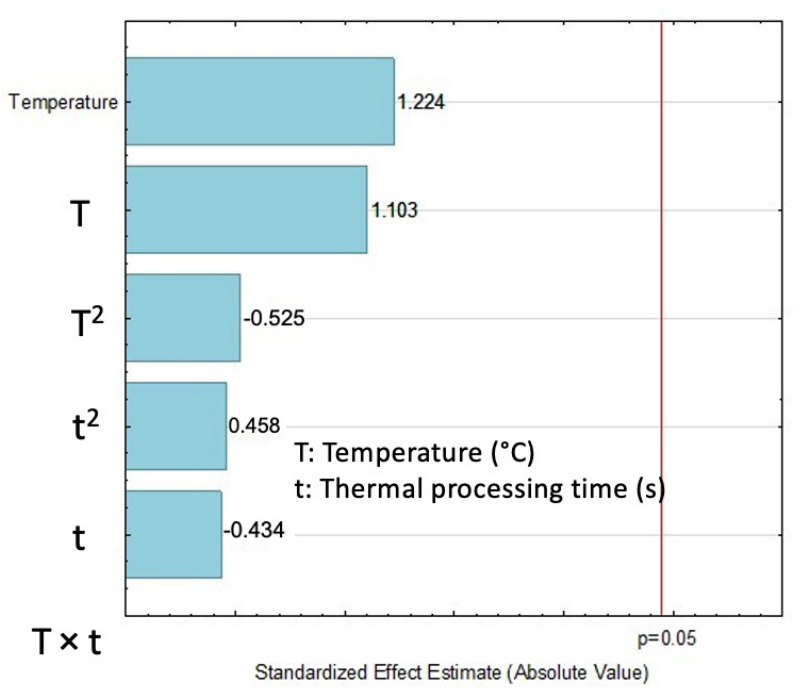
Figure 4. Effect of steam processing temperature “T” (°C) and thermal processing time “t” (s) on TEAC (uMTE/g EO) of EO: Pareto chart.